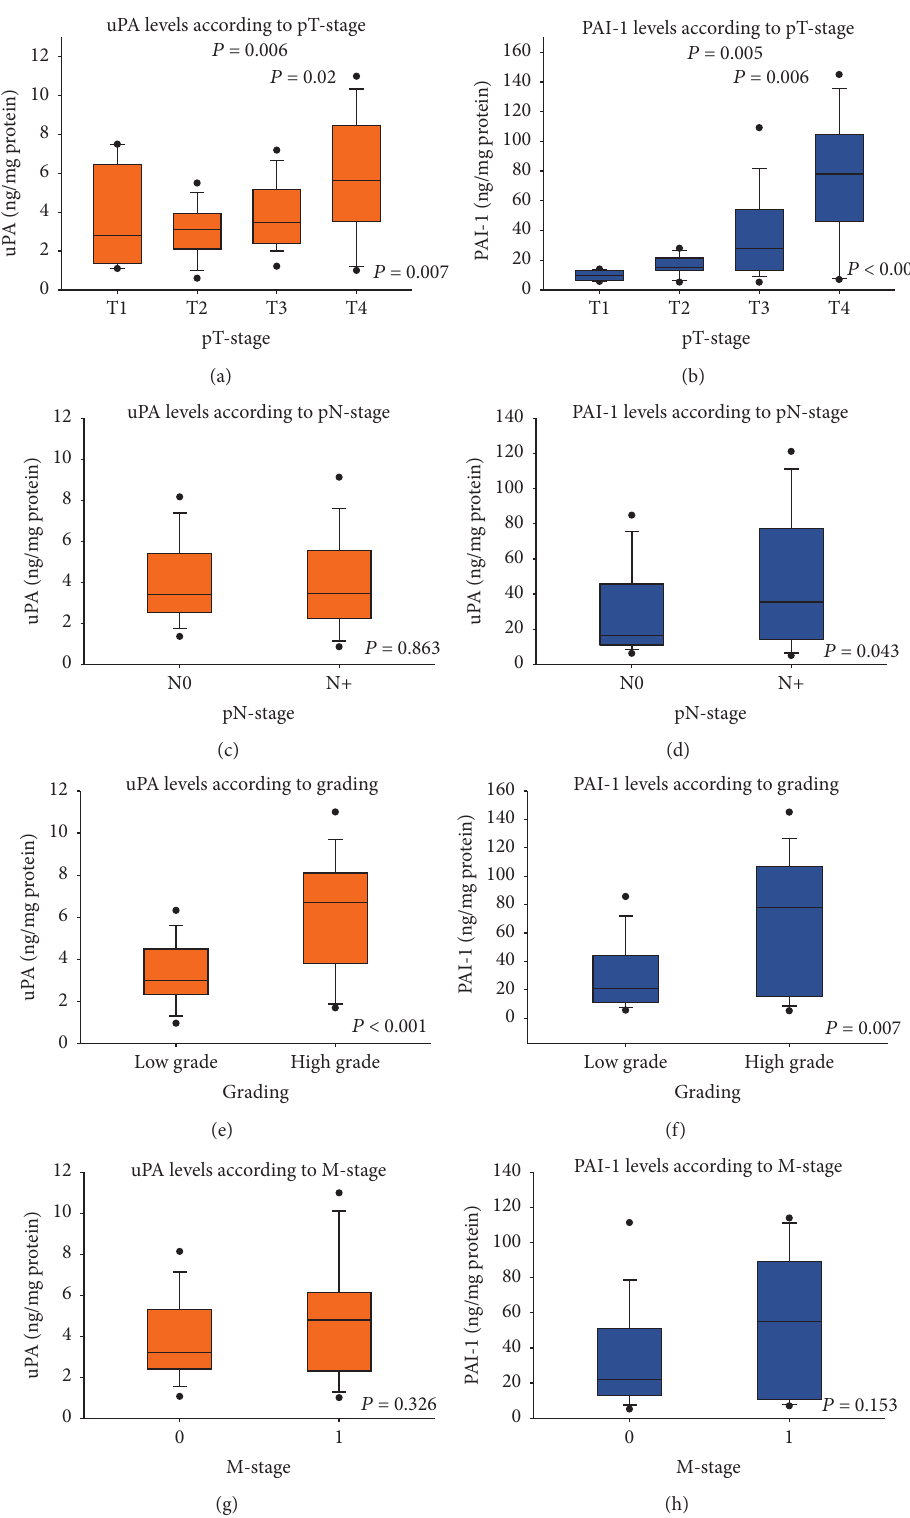
Figure 3: Validation set: mean tissue levels of uPA and PAI-1 according to pT-stage (a and b), pN-stage (c and d), grading (e and f), and M-stage (g and